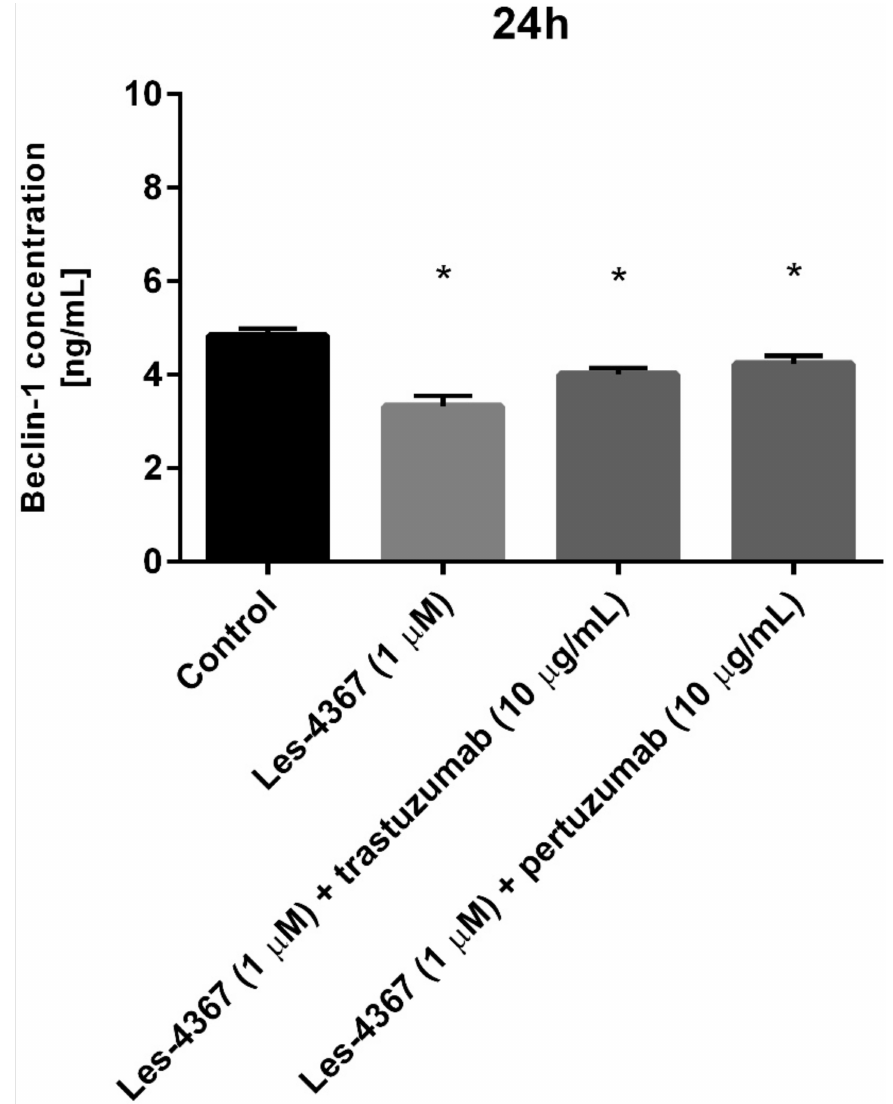
Figure 7. Concentrations of Beclin-1 in AGS cells after 24 h incubation with Les-4367 (1 µ M) and combined with anti-HER2 antibodies. The ANOVA and Tukey tests were used to demonstrate differences between the control cells and the cells exposed to varying concentrations of the tested compounds. * p ≤ 0.05 vs. control